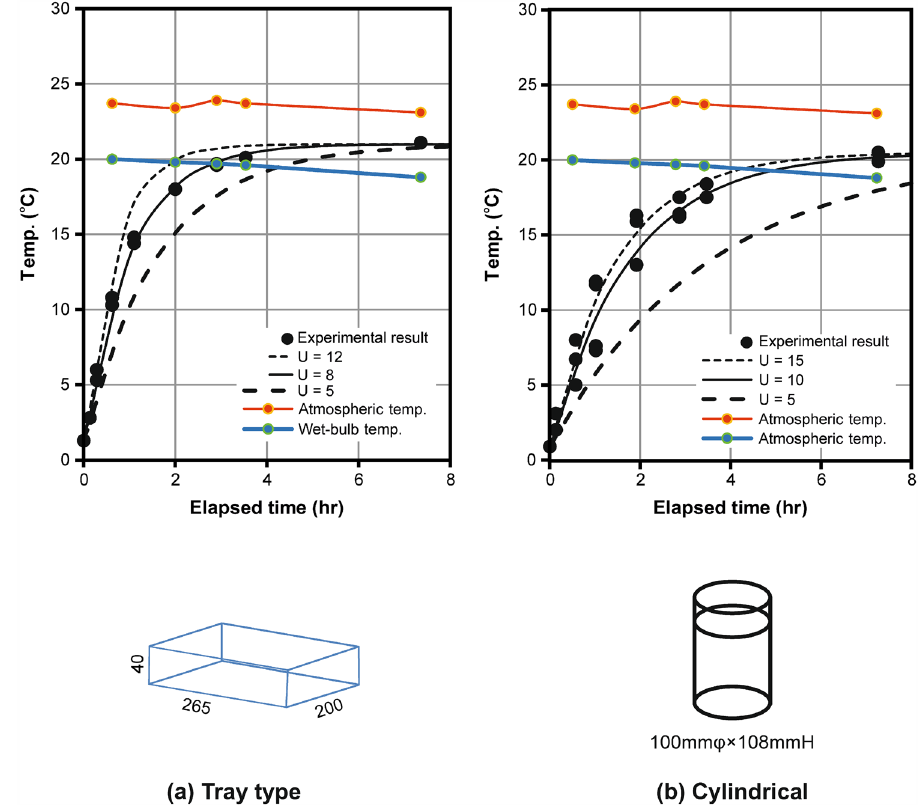
Fig. 3 Preliminary experiment for heat transfer coefficient estimation. Unit of U is kcal/ m 2 h